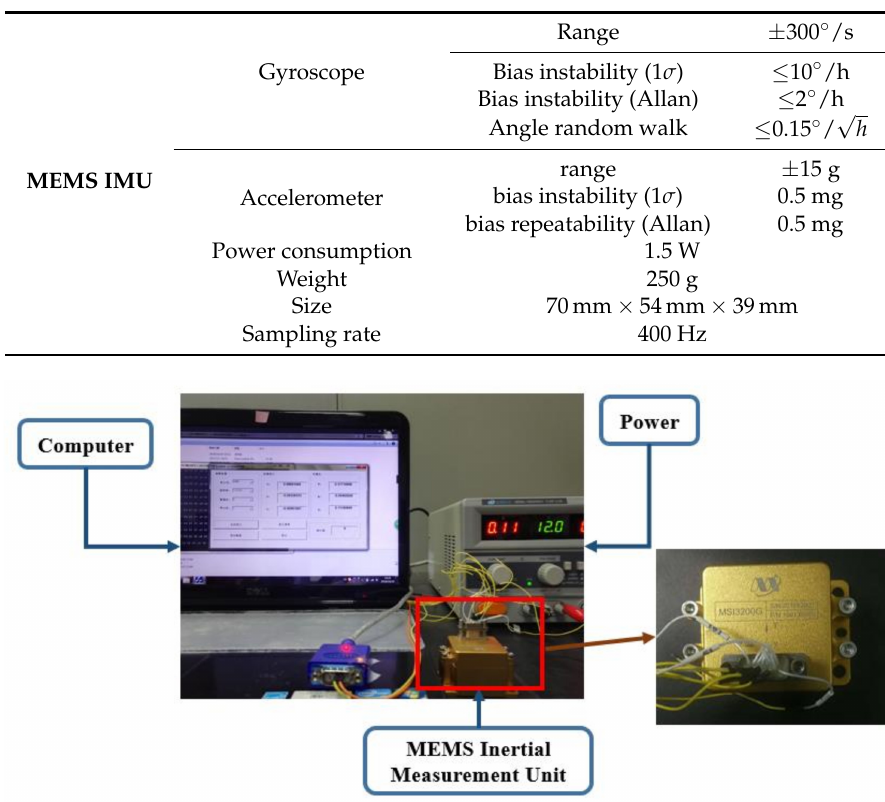
Table 1. Specifications of MSI3200 IMU.